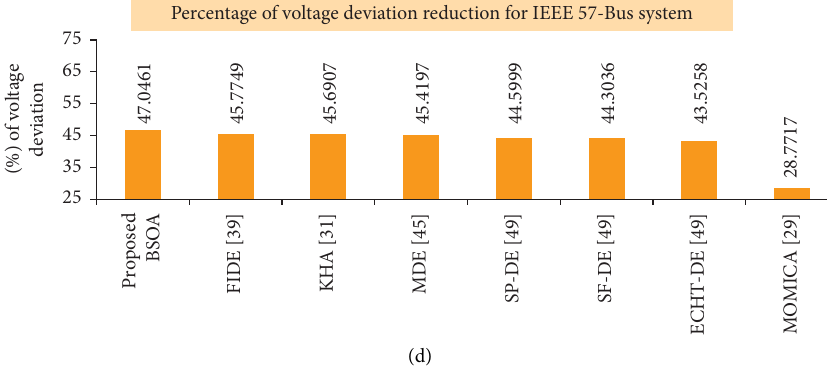
Figure 11: Percentage of fuel cost savings, active power loss reduction, voltage deviation reduction, and voltage stability improvement of the IEEE 57-bus system from base case: (a) fuel cost savings (Case 17); (b) active power loss reduction (Case 18); (c) voltage stability im- provement (Case 19); (d) voltage deviation reduction (Case 20).